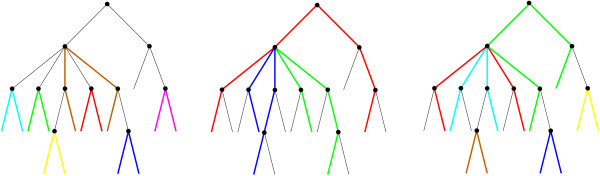
Three different path-systems on a tree with 15 leaves. Each path is shown in a distinctive color, and unused edges of the tree are shown as thin black lines. Clearly, no two paths share an edge, i.e., the corresponding collection of pairs of leaves is phylogenetically independent. Note that the paths are not necessarily vertex-disjoint.